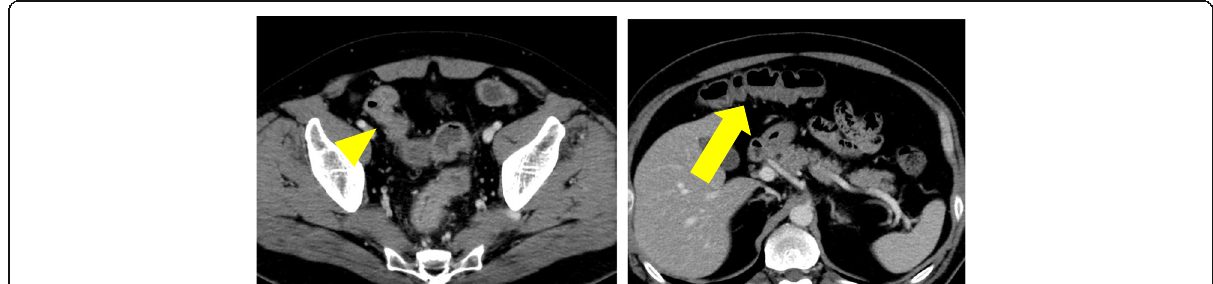
Fig. 2 First abdominal CT scans. CT revealing edematous thickening bowel from the rectum to the transverse colon (arrow). The appearance of the cecum is normal (arrowhead)